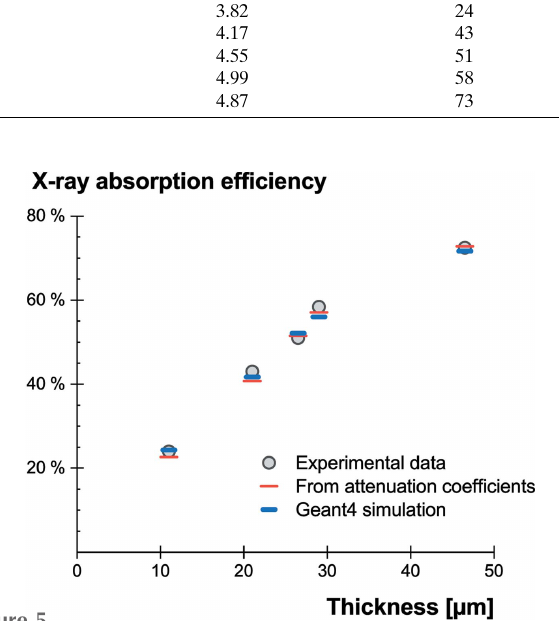
Figure 5 Absorption efficiencies at 15.4 keV from experimental data, compared with values computed from the X-ray attenuation coefficients and from Geant4 simulation.